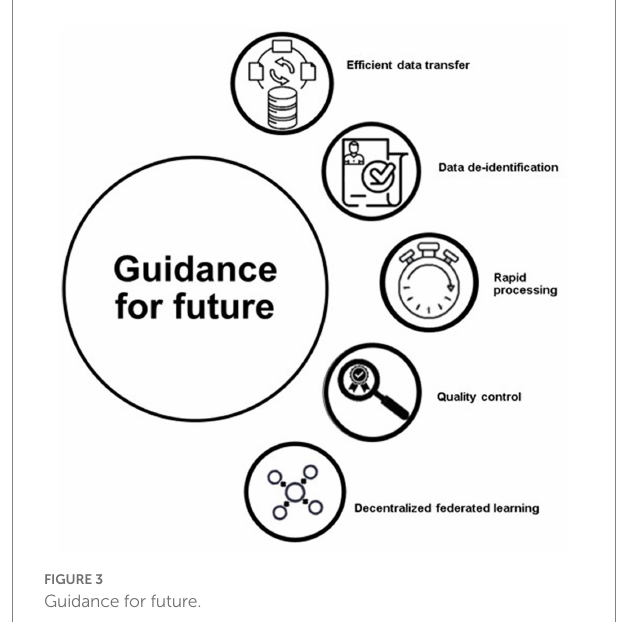
FIGURE 3 Guidance for